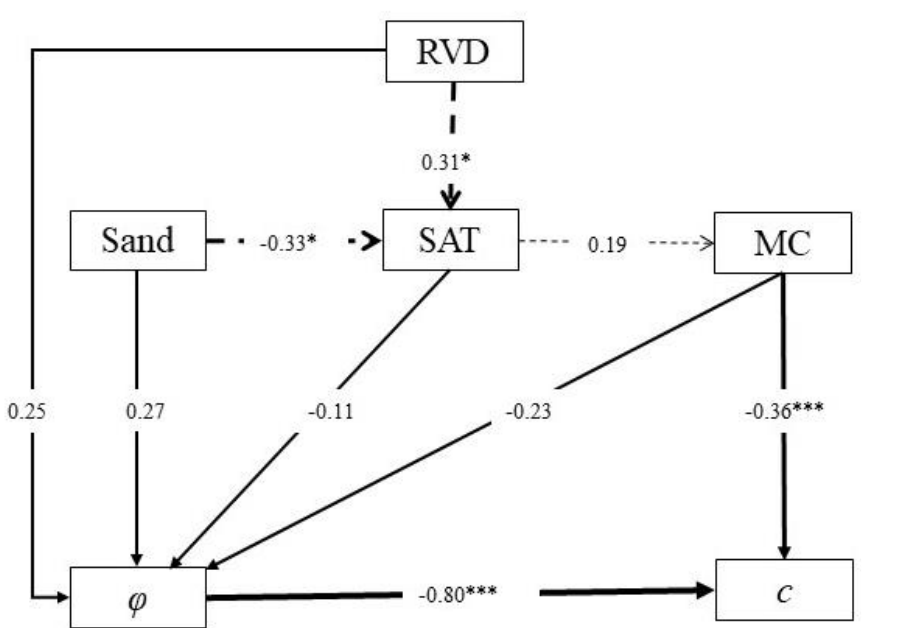
Figure 6. Structural equation models of the soil properties and root biomass on internal frictional angle ( ϕ ). ( χ 2 = 6.160; df = 6; p = 0.406, > 0.05; GFI = 0.963, > 0.900; RMSEA = 0.023, < 0.080). Numbers on arrows are standardized path coefficients. The width of arrows indicates the strength of the causal influence. Solid arrows mean a direct effect on internal frictional angle; dashes represent an indirect path to the internal frictional angle. MC stands for moisture content; RVD stands for root volume density; SAT stands for total porosity; ϕ stands for internal frictional angle, c stands for cohesive force. *** was significantly correlated at the.01 level (bilateral). * Significant correlation at 0.05 level (bilateral). Table 2. Standardized direct and indirect effects of internal frictional angle. Sand